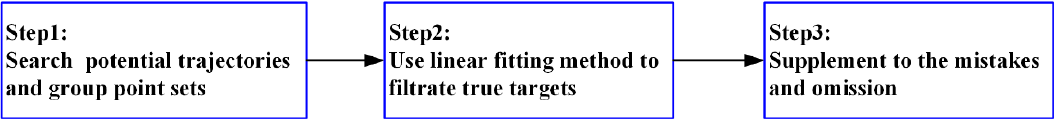
Figure 7. Flowchart of the proposed CFS method.